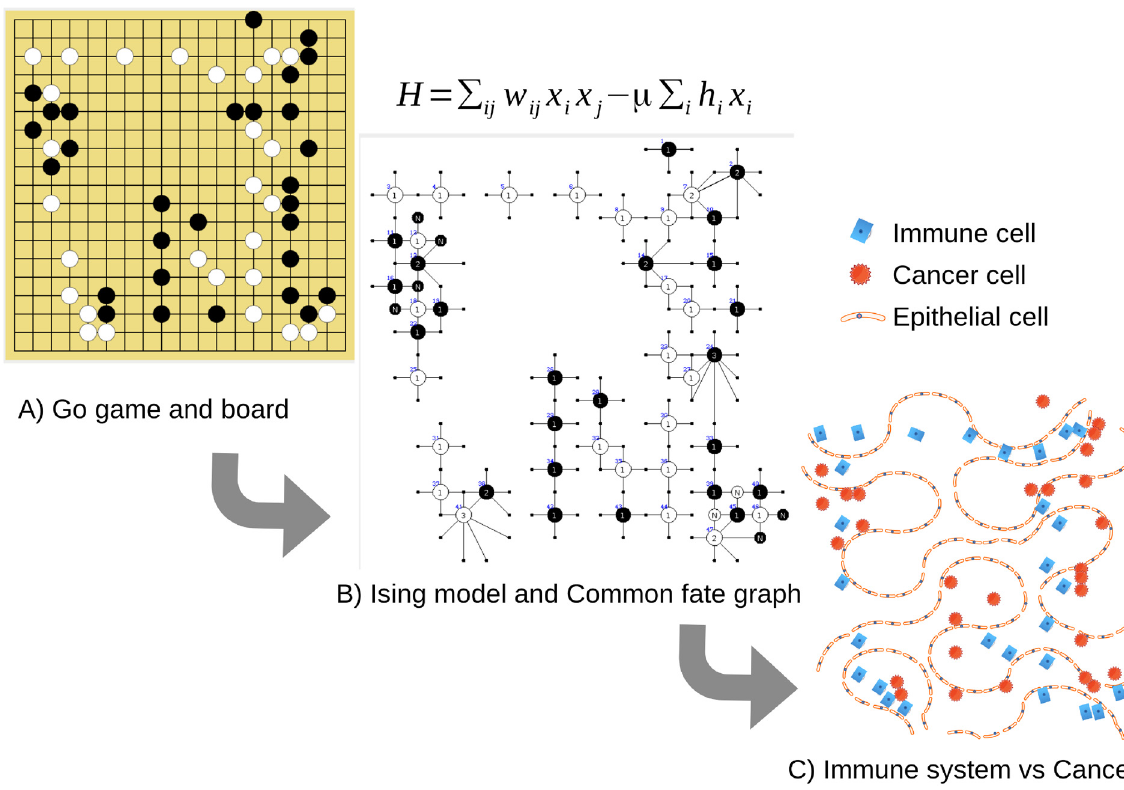
Fig 1. Scheme of cancer as Go gaming. Go gaming cancer processes: (A) Go game in an intermediate state having black—white dominance in equilibrium; (B) Ising hamiltonian and the CFG from the mentioned state; (C) over tissues, the cancer cells expansion versus the immune system behave.